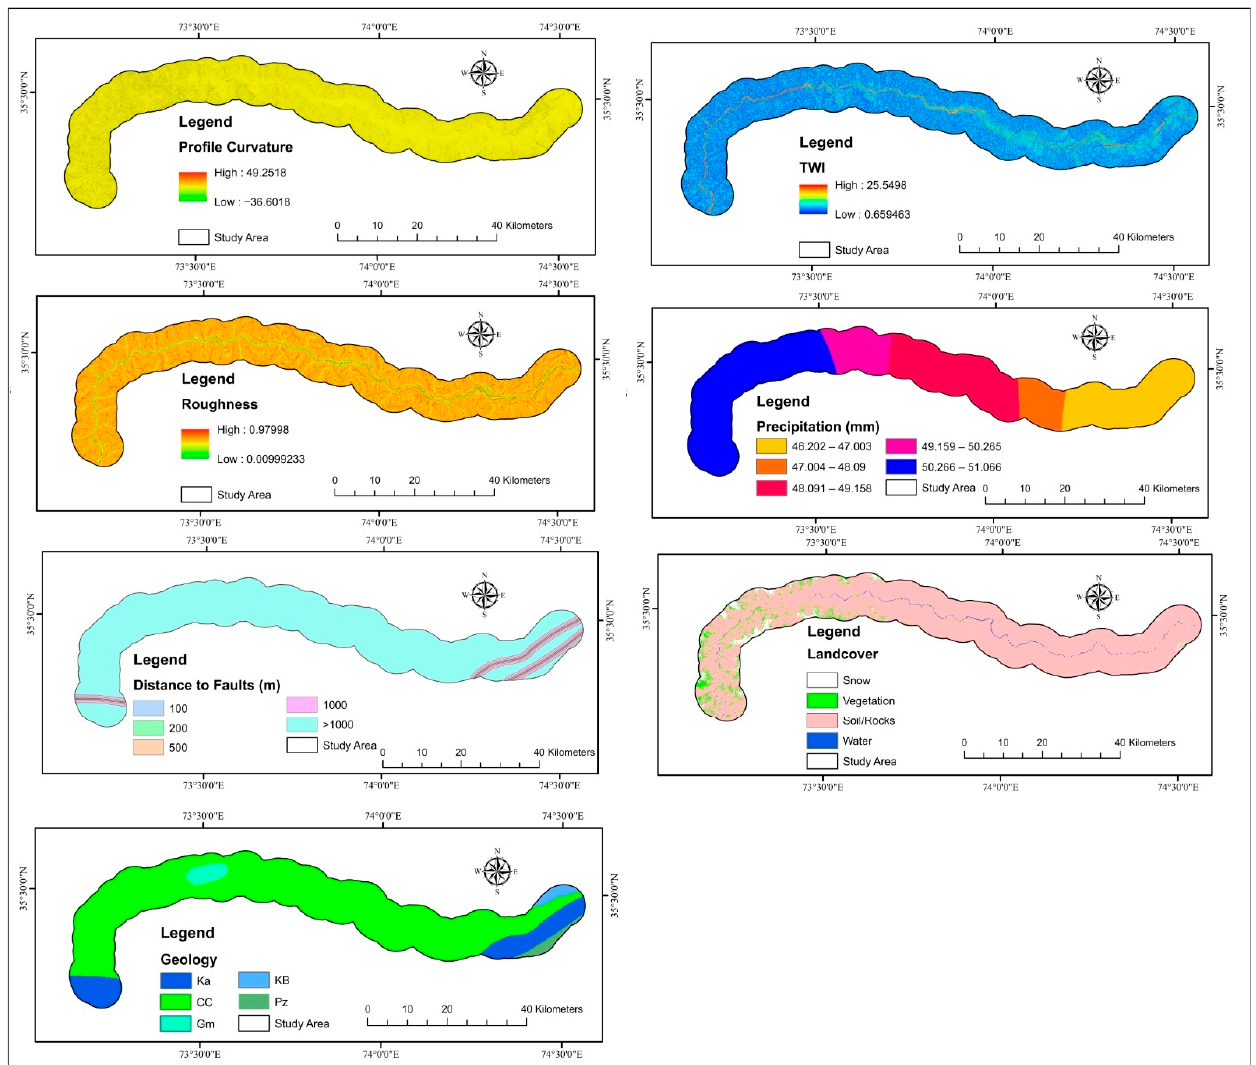
Figure 7. Landslides factors used in the research area.